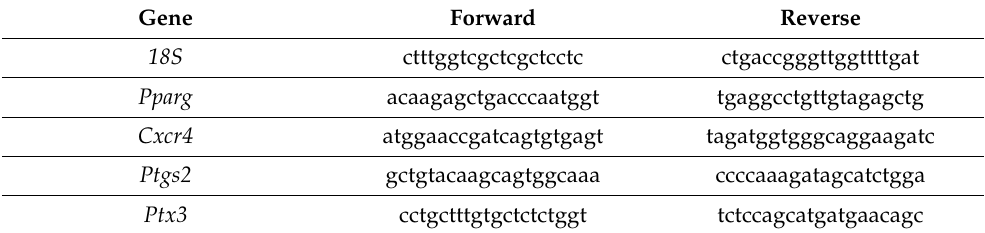
Table 1. PCR primers